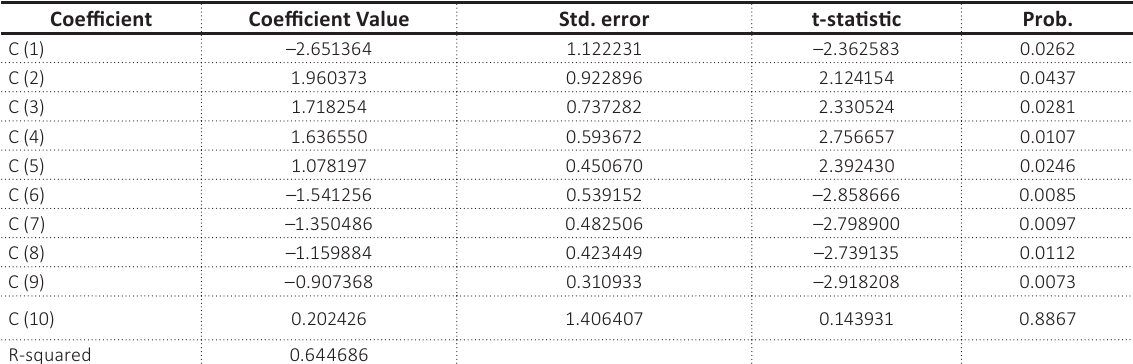
Table 8. Long-run causality variable (least squares) of MIMF and